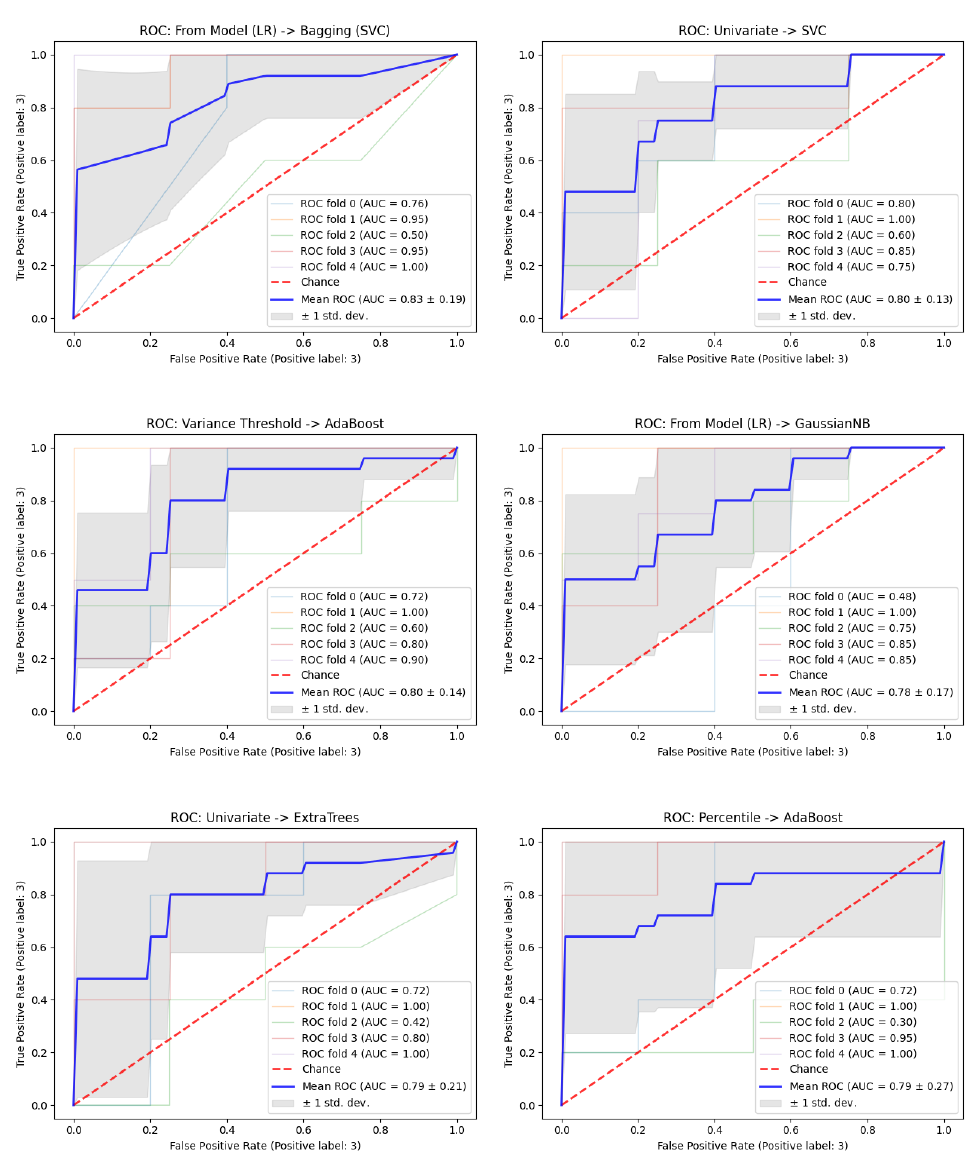
Figure 6. ROC curves obtained for the selected